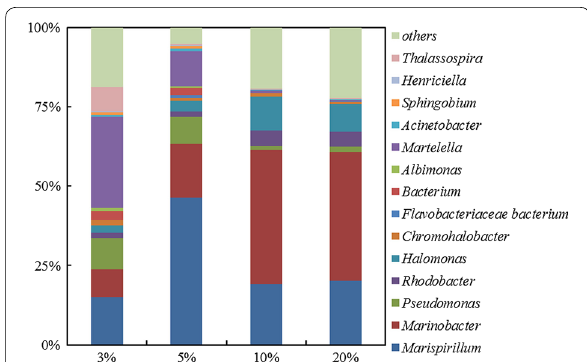
Fig. 2 Community structure of CY-1 under different salinity. The genome DNA was extracted from samples collected from CY-1 cul- tured batch-wise (second round) under different salinities when 50% phenanthrene was removed. The sequence data were separated into different OTUs with 97% identity. The annotation of each OTU was identified using BLAST on NCBI website